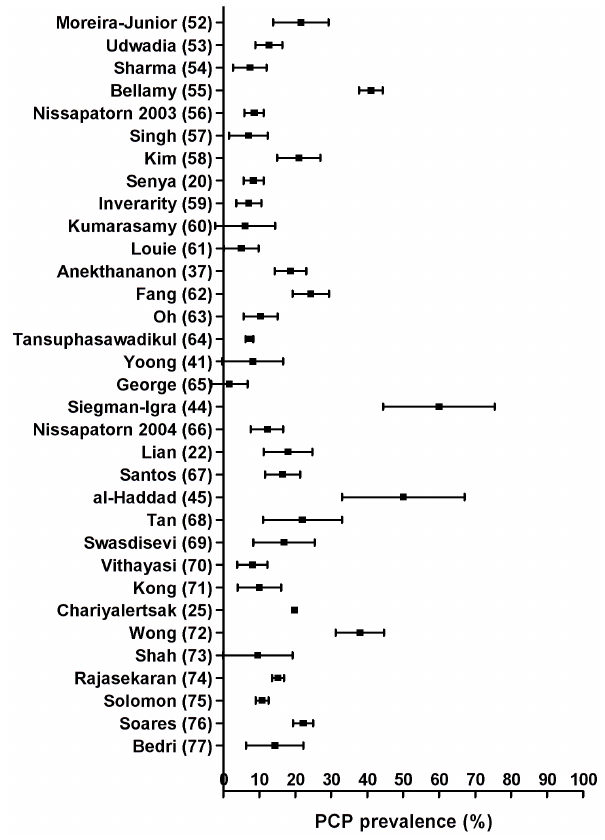
Figure 3. Prevalence of PCP in studies included for primary analysis, indicating heterogeneity of data set. Confidence intervals for point prevalences were determined by adjusted Wald